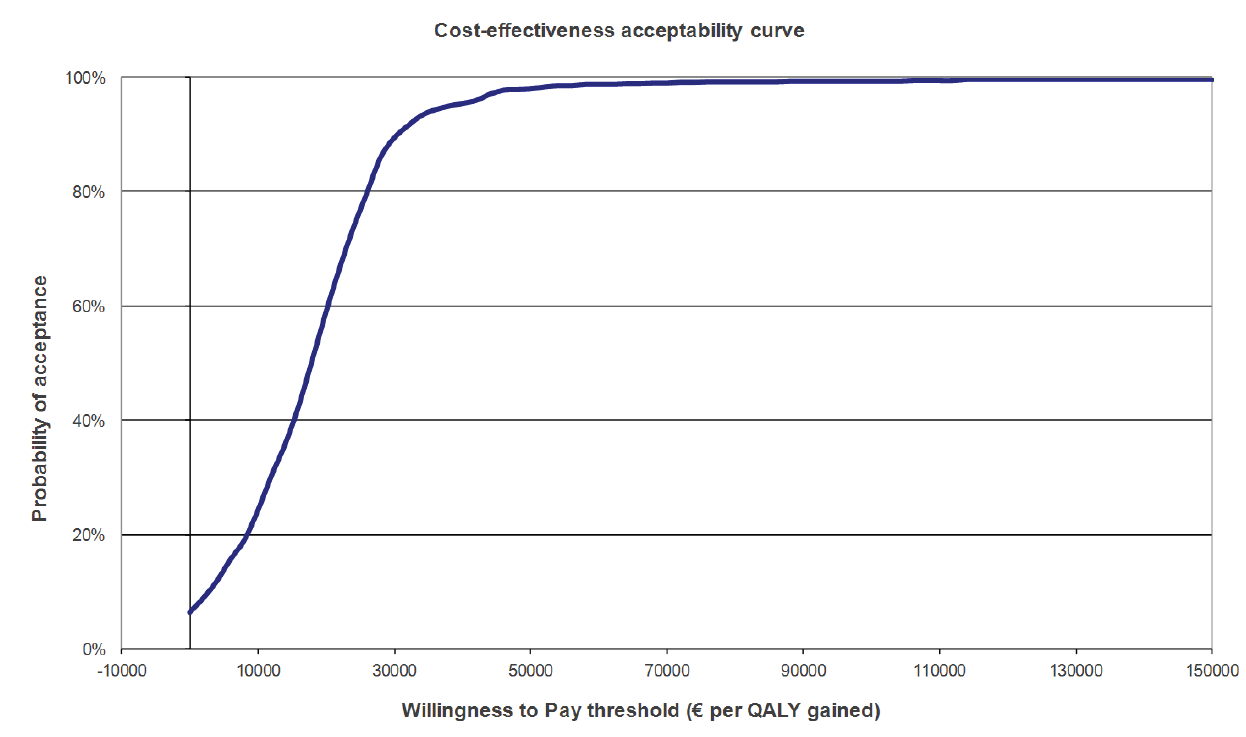
Figure 4. Cost-effectiveness Acceptability